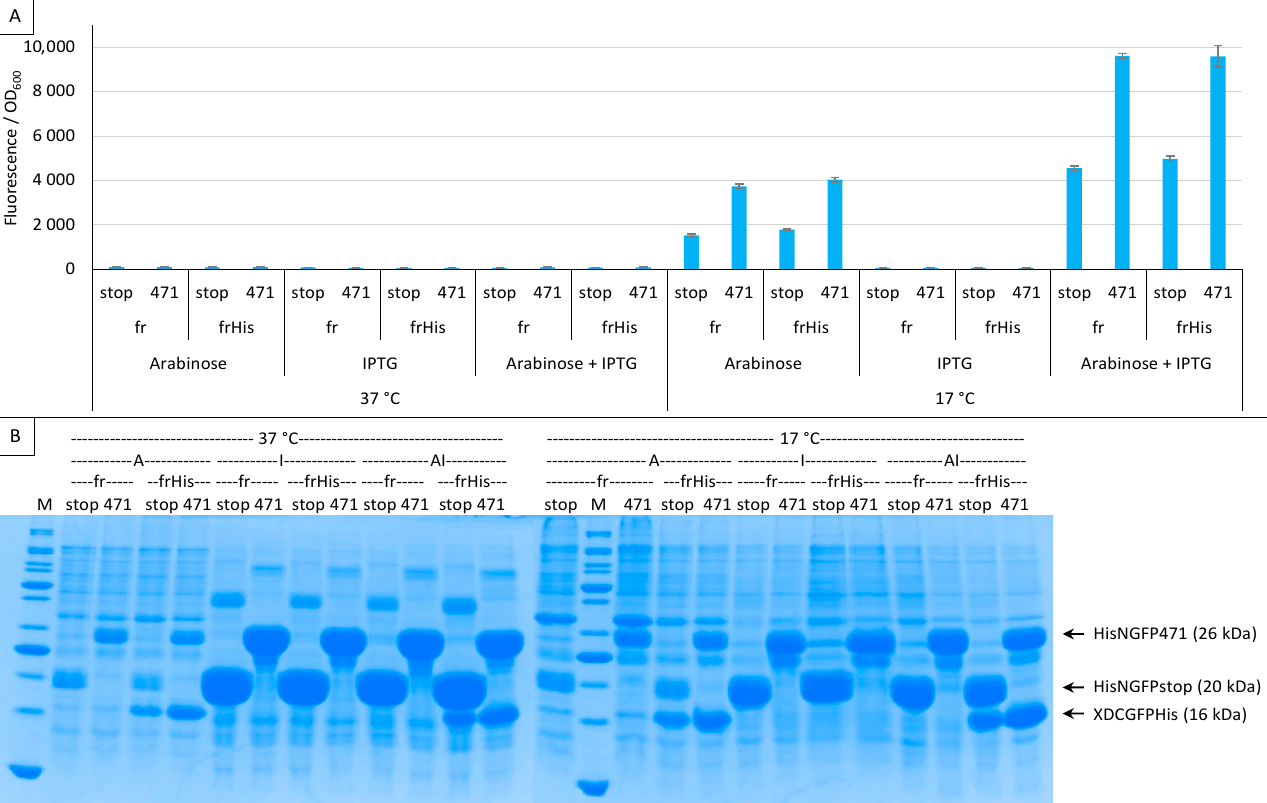
Figure 8. Single and double induction of expression . Split-GFP reassembly assay results as obtained with different inducer combinations and with the negative (stop) and positive (471) controls of the 471/XD interaction with the fr GFP reporter at 37 °C and 17 °C. Results obtained using His-tagged (frHis) and non-His-tagged (fr) XD-CfrGFP are shown. ( A ) Fluorescence to OD 600 ratios. Inducers and inducer combinations are indicated on the x-axis. ( B ) SDS-PAGE analysis of the expression of the NGFP and CGFP fusions. A, arabinose; I, IPTG; AI, arabinose plus IPTG. M, molecular size markers (200, 150, 100, 85, 70, 60, 50, 40, 30, 25, 20, 15, 10 kDa). The expression leakage of the vector encoding His-NfrGFP fusions precluded the ative (stop) and positive (471) controls persists in the absence of NfrGFP expression. Fig- ure 8B confirms that, in the presence of arabinose only (CGFP fusion inducer), the bands 17 °C, although this co-expression only led to detectable fluorescence values at the optimal temperature of 17 °C. By contrast, the addition of IPTG only (NGFP fusion inducer) re- sulted in a significant increase in the amount of both His-NfrGFP-stop and His-NfrGFP- 471 but in no detectable expression of XD-CfrGFP-His whatever the temperature (Figure 8B), which is in line with the observed absence of fluorescence when this inducer was used alone (Figure 8A). To overcome the pET11a expression leakage issue, we transformed cells with either one or the two plasmids of the assay and used both inducers (arabinose + IPTG) in all experimental points. In this experiment, only fr was used because the His-tagged version of XD-CGFP did not exist for sg100. As expected, both plasmids were required to elicit fluorescence, and at 17 °C only (Figure 9A).